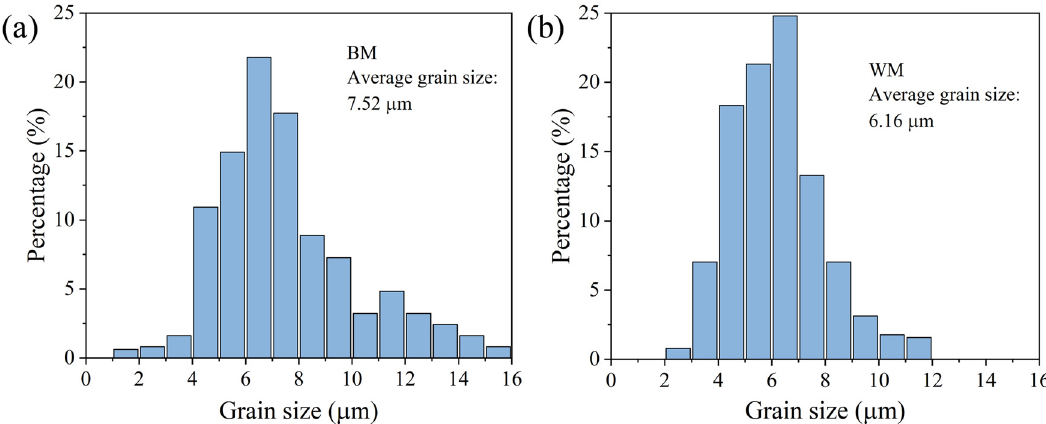
Figure 3: Probability distributions of grain size of the 2.25Cr1Mo0.25V steel: ( a ) BM and ( b ) WM. The average grain size of BM and WM are determined as 7.52 and 6.16 μ m, respectively.